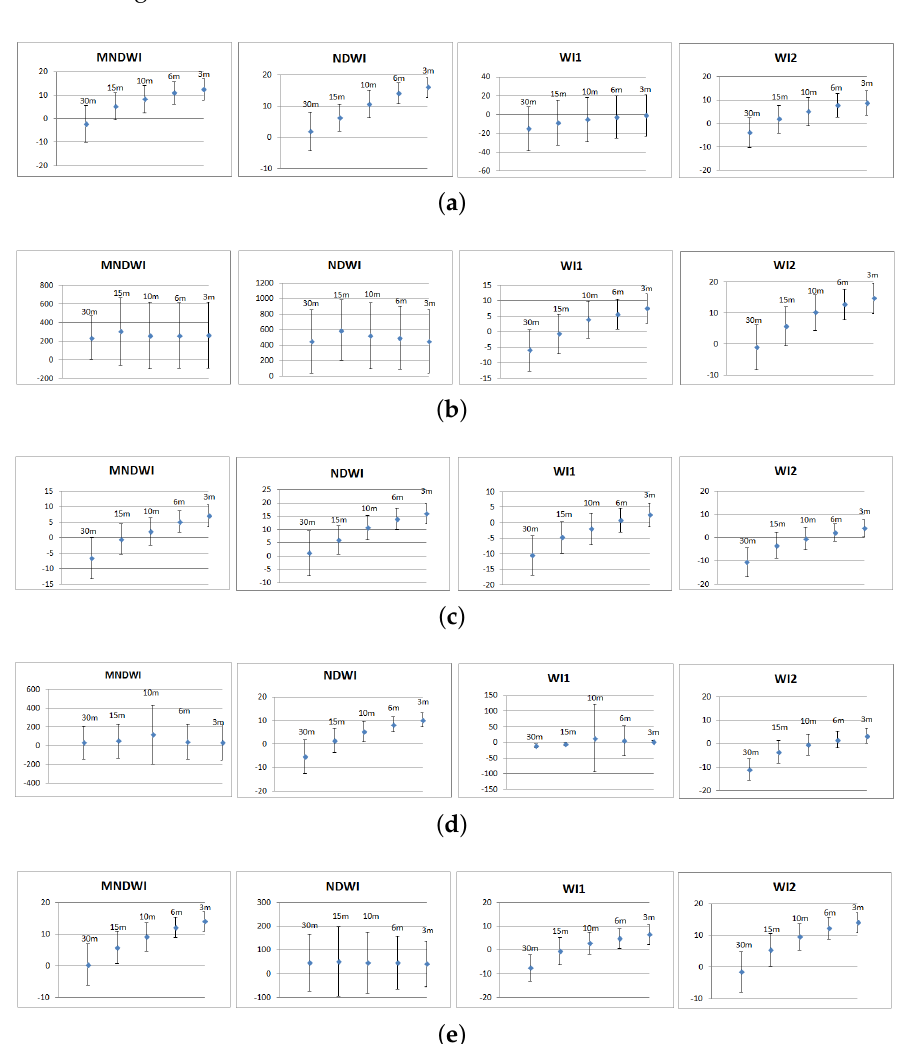
Figure 17. The graphs show the mean distance and standard deviation behavior according to the different factor of bicubic interpolation used on the Landsat images to analyze accuracy assessment in the coastline detected in Guadalfeo river delta. ( a ) The image captured on 18 July 2010. ( b ) The image captured on 23 May 2013. ( c ) The image captured on 25 October 2014. ( d ) The image captured on 12 December 2014. ( e ) The image captured on February 6,